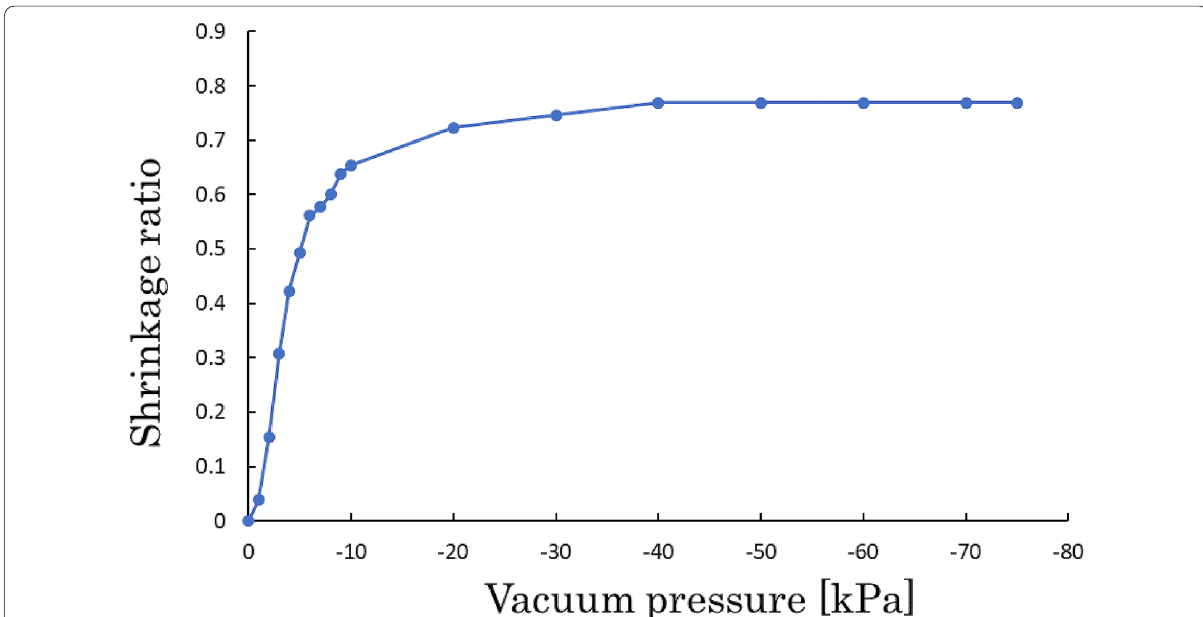
Fig. 8 Relationship between the internal air pressure and shrinkage ratio of the inner diameter of a rubber-band gripper. The gripper shrank rapidly when the inside air pressure decreased. The shrinkage ratio changed gently when the inside vacuum pressure exceeded constant when the air pressure exceeded 30 −